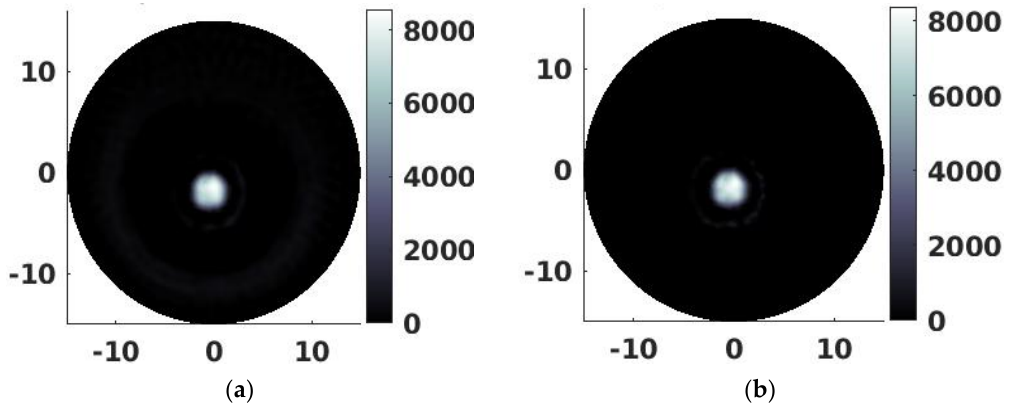
Figure 4. Reconstructed photoacoustic images of the target in a phantom using the full zone-based FE-PAT algorithm ( a ) and localized FE-PAT algorithm in a ROI with a radius of 4.0 mm ( b ).